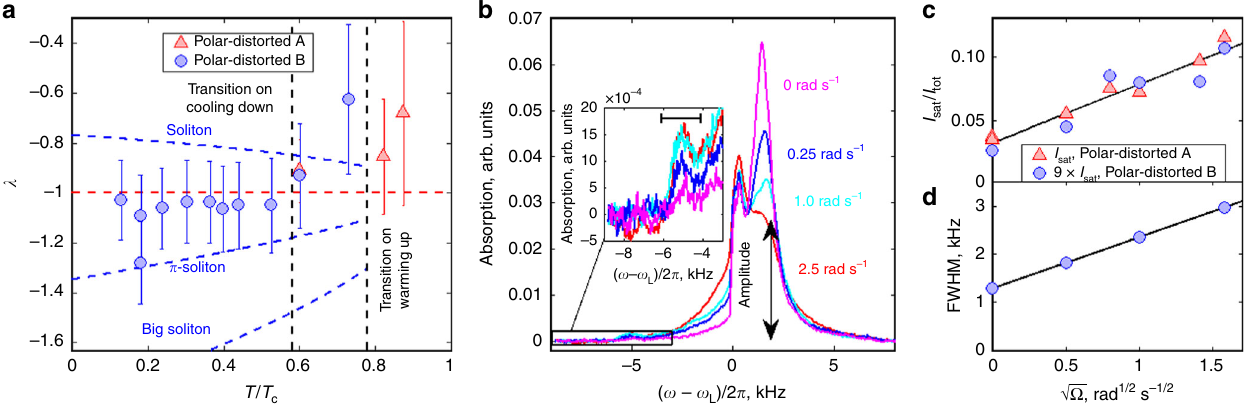
Fig. 3 NMR spectra and spin-solitons in the polar-distorted phases. a Frequency shift of a characteristic satellite peak in the NMR spectrum expressed via parameter λ as a function of temperature in the PdA and PdB phases. In the PdA phase, the measured values reside slightly above the theoretical prediction for a ^ d -soliton with π winding, shown as the red dashed line. The difference is believed to be caused by disorder introduced by nafen, as in the polar phase 20,70 . The corresponding values in the PdB phase for the lowest-energy ^ d -soliton (marked “ soliton ” ) and its antisoliton (marked “ big soliton ” ), as well as the combined π -soliton (see text) are shown as dashed blue lines. The π -soliton values turn out to be in the same ratio with respect to the experimental points as in the PdA phase. The error bars are based on the spectral width of the observed feature and denote the uncertainty in the position of the satellite peak, as illustrated by the black bar in the inset of b for the PdB phase. The range marked by an error bar corresponds to the doubled full width at half maximum (FWHM) of the satellite peak in the PdB phase (1 kHz). In the PdA phase, due to improved signal-to-noise ratio, the uncertainty is twice smaller (0.5 kHz). b The plot shows the measured NMR spectrum in the PdB phase at 0.38 T c for different HQV densities, controlled by the angular velocity Ω at the time of crossing the T c . The presence of KLS walls produces characteristic features seen both as widening of the main line (with small positive frequency shift) and as a satellite peak with a characteristic negative frequency shift. The inset shows magni fi ed view of the satellite peak. c The satellite intensity in the PdA phase at 0.60 T c (blue circles) and in the PdB phase multiplied by a factor of 9 (red triangles) at 0.38 T c show the expected ffiffiffiffi p Ω -scaling. The solid black line is a linear fi t to the measurements including data from both phases. The non-zero Ω = 0 intersection corresponds to vortices created by the Kibble – Zurek mechanism 1,2,20 . d The FWHM of the main line, determined from the spectrum in b , gives FWHM ≈ 3 kHz for 2.5 rad s − 1 . FWHM for other angular velocities is recalculated from the amplitude of the main NMR line, shown in b , assuming constant area